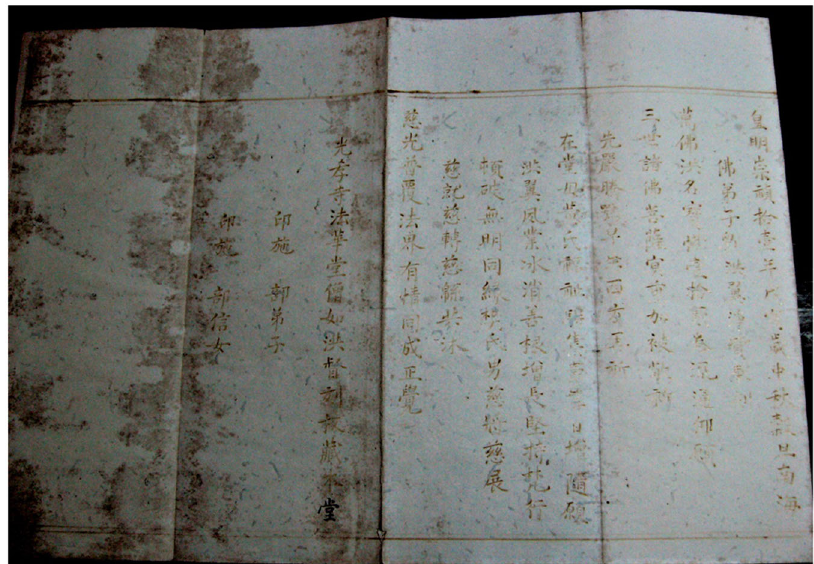
Fig. 3 Last page of Foming jing 佛 名 經 or Scripture of the Names of the Buddhas, a confessional ritual text. This blood scripture is dated to 1638 CE and the spread measures 8 × 26 inches. Currently, it is housed in the monastic library of Yongquan Monastery on Mount Gu in Fujian province. Photograph by the author.